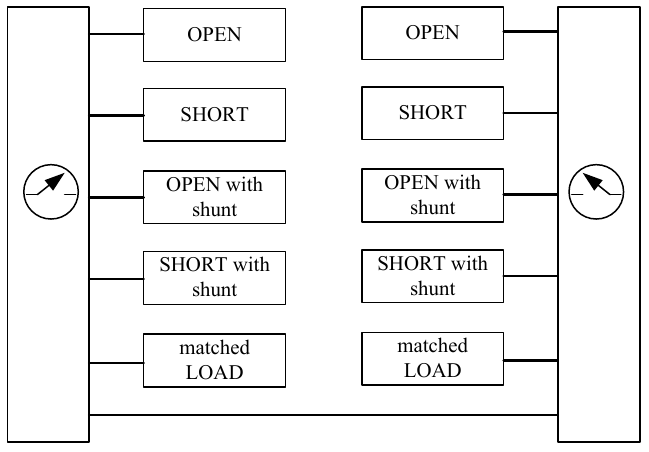
Fig . 1 . Structural circuit on the electronic calibration unit .